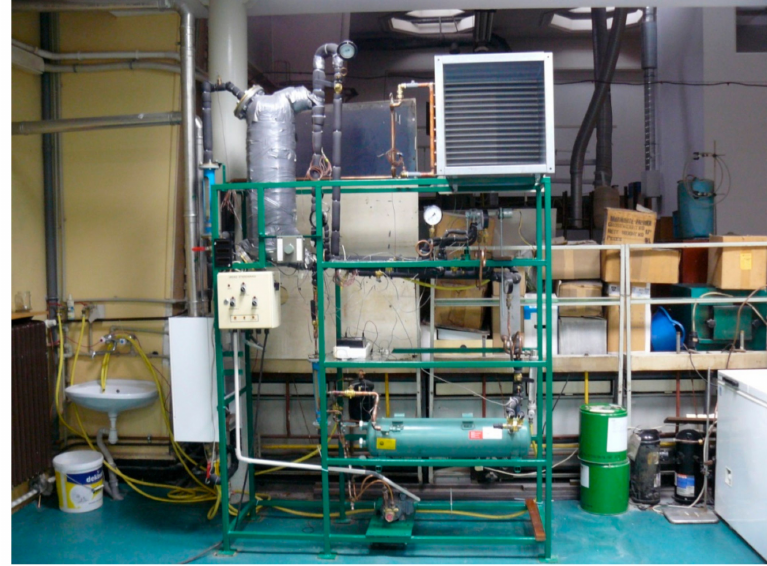
Figure 6. A general view of a micro-power ORC test stand implemented in 2009 at the Wrocław University of